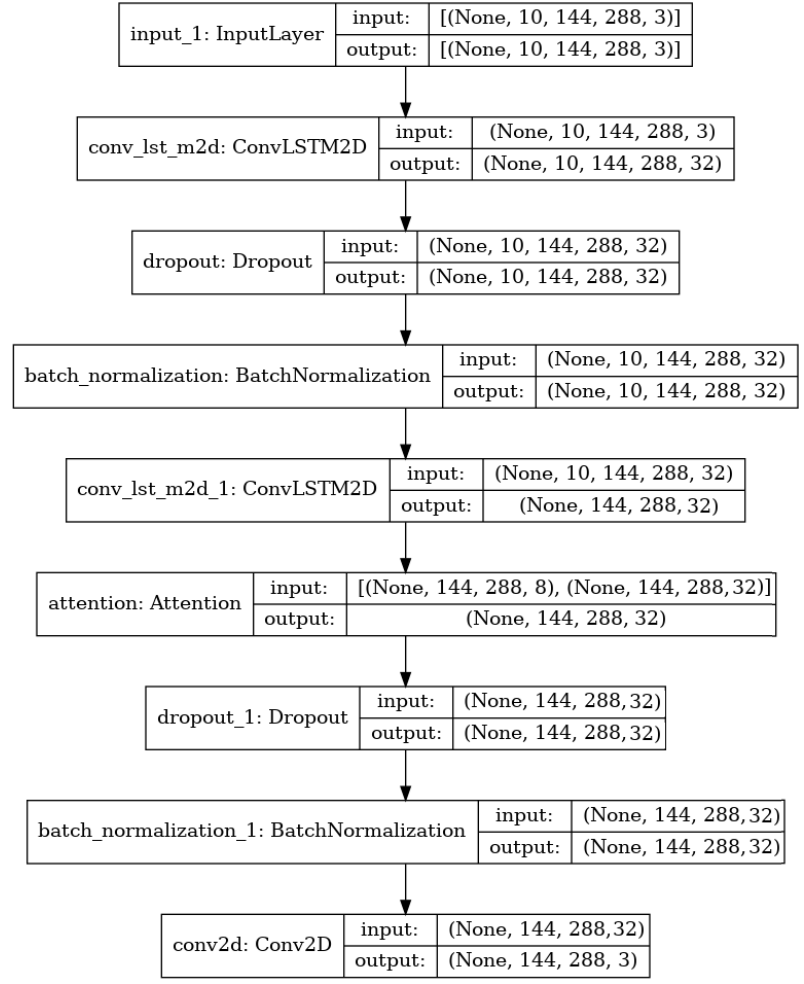
Figure 2. Plot of ConvLSTM-SA model for sequence-to-one prediction.